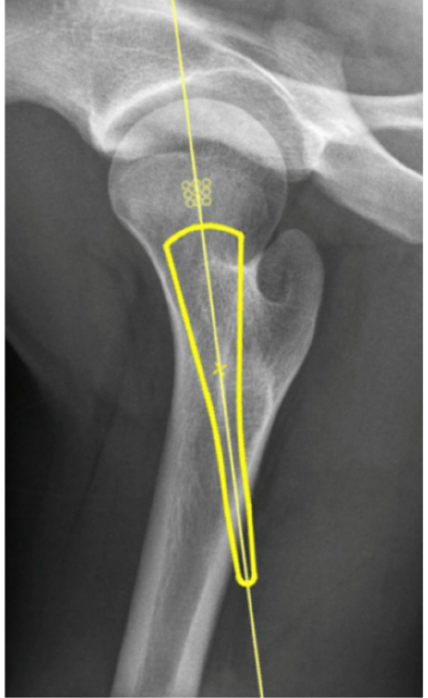
Figure 5. Digital templating of a STHA (lateral view) in a patient with excessive ante torsion of the femoral neck is an obvious contraindication for an implant with orientation parallel to the femoral